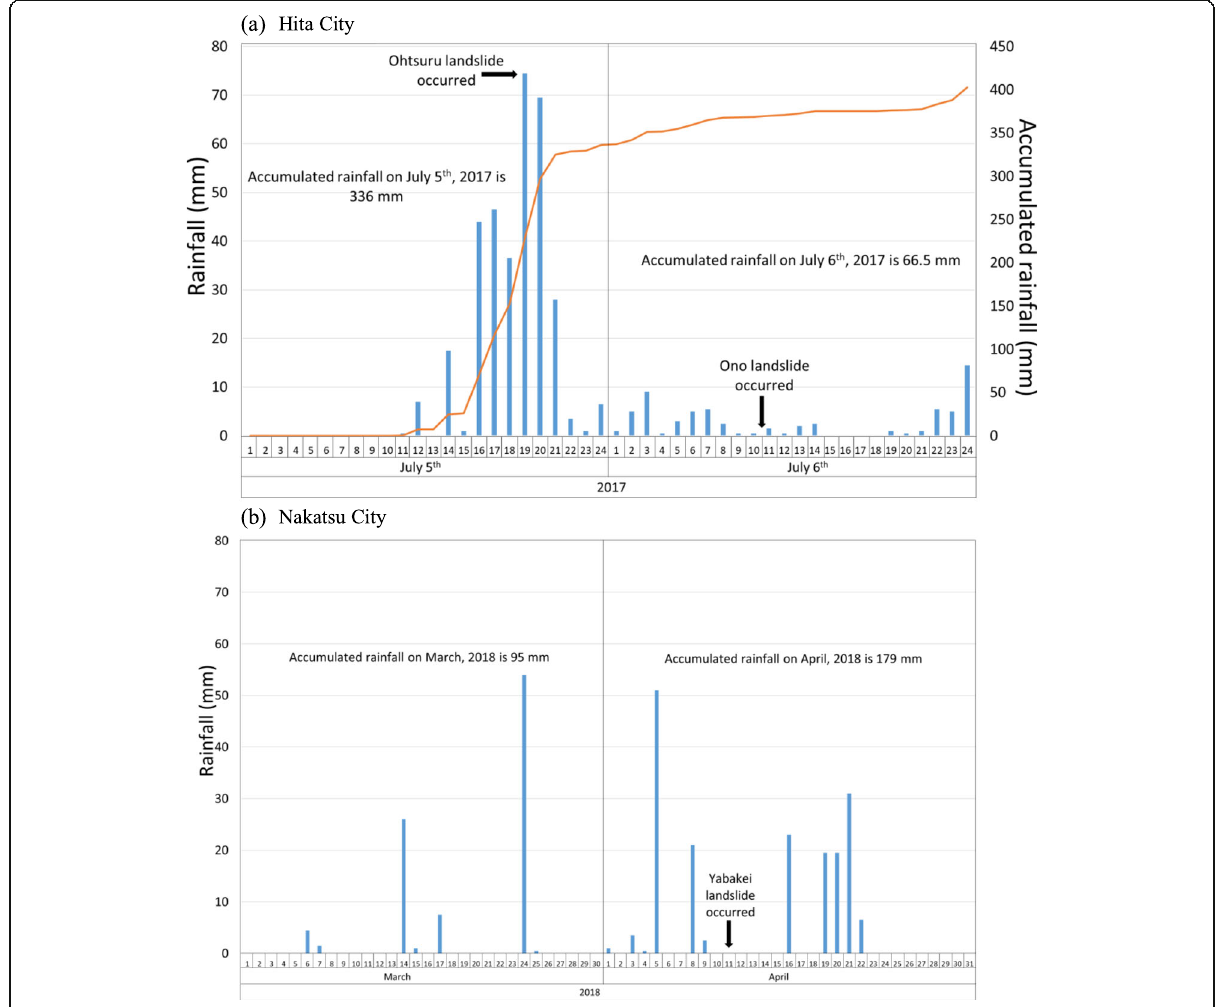
Fig. 2 Precipitation data on research area; ( a ) Hita City and ( b ) Nakatsu City (Japan Meteorological Agency